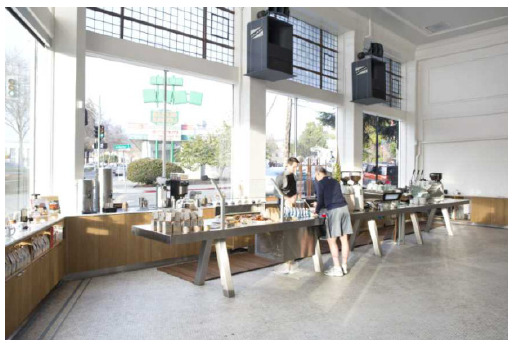
Figure 38. Hand drip coffee at Blue Bottle.